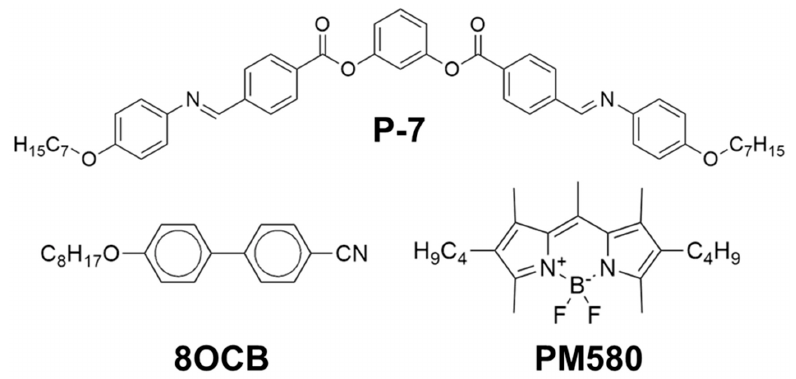
Figure 1. Chemical structures of P-7, 8OCB, and PM580.